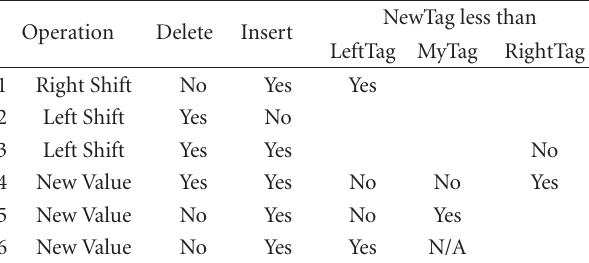
Figure 8: Sample sorting of 16 values by 4 linear sorters. Table 1: Logic for sorter node’s shift